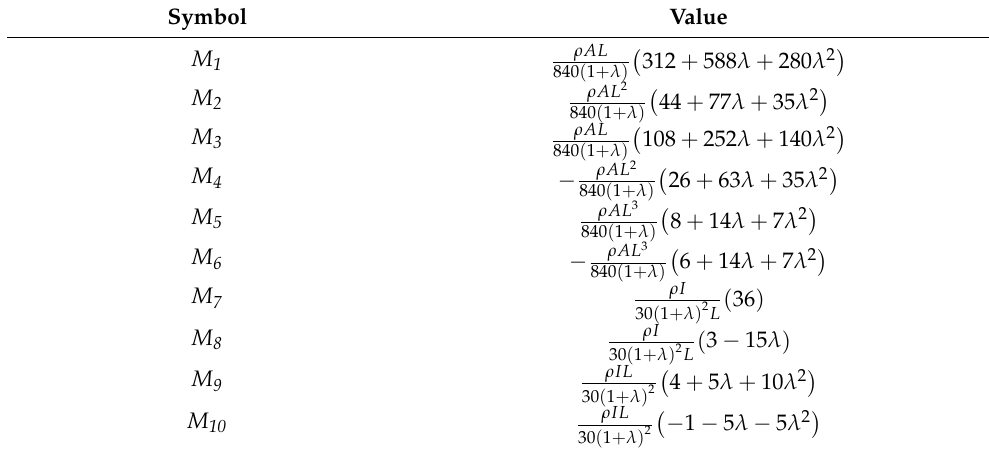
Figure 3. Coordinates of a beam element in xz and yz planes. Table 1. Components of mass matrix.